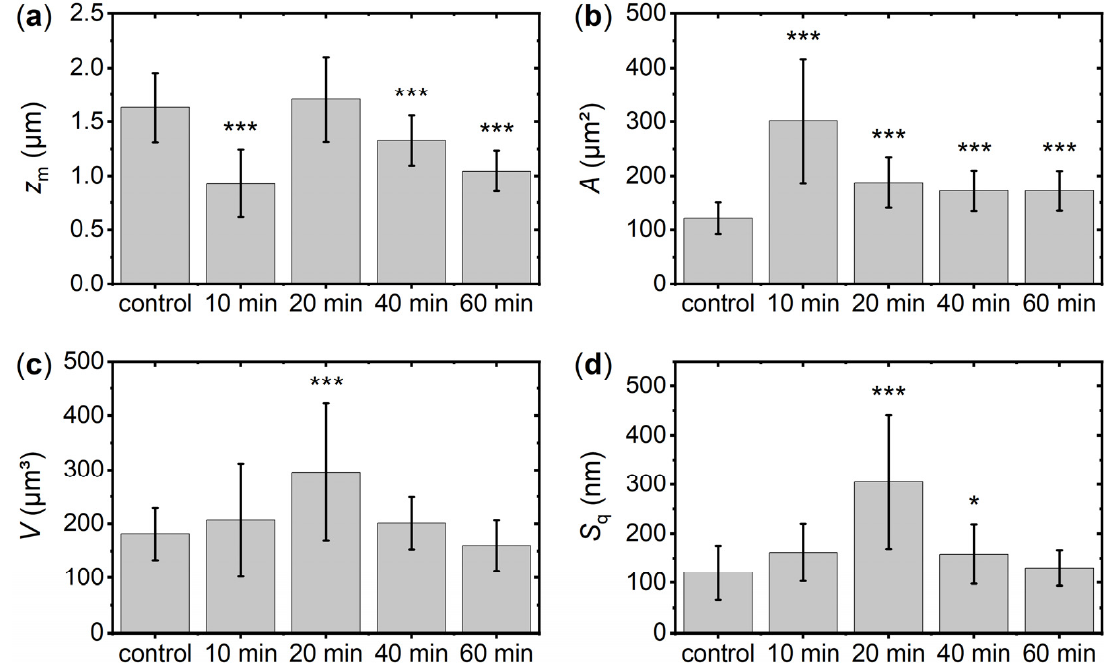
Figure 6. Results of statistical analyses of the morphological parameters of acute lymphoblastic leukemia cells cultured on a glass surface (control) and TiO 2 -m coatings for different times. ( a ) Average mean height of the cells z m . ( b ) Average contact area with the substrate A . ( c ) Average cell volume V . ( d ) Average RMS roughness of the cell surface S q . Values represent averages of up to 30 individual cells with the standard deviations given as error bars. Significances with respect to the control are indicated as * ( p < 0.05) and *** ( p < 0.001).